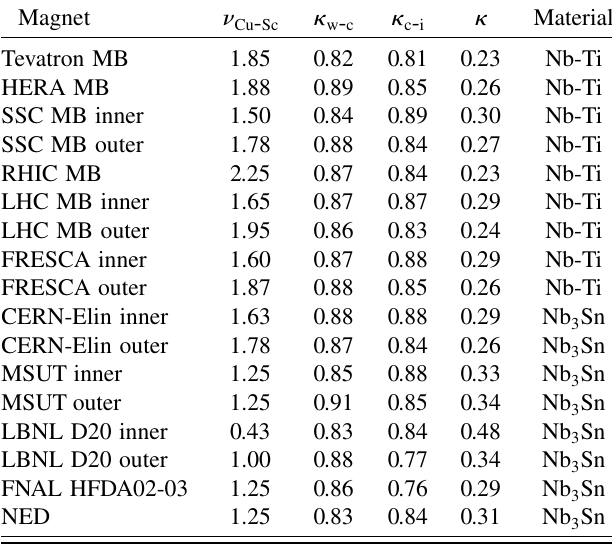
TABLE I. Filling factors for cables used in some supercon- ducting dipoles.